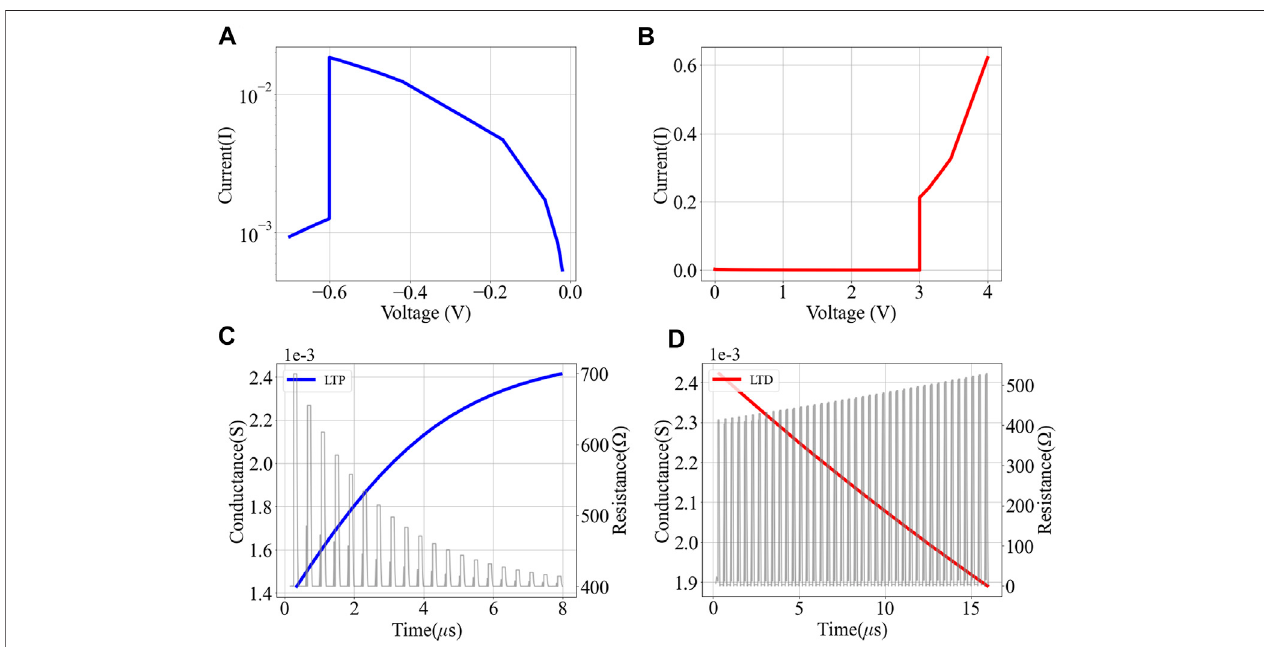
FIGURE 6 | Simulation results of ReSe 2 RRAM Verilog-A compact model using HSPICE. Simulated I-V curve of (A) RESET and (B) SET under DC sweep. No current compliance was applied to the simulation, causing an increasing current response after passing the threshold voltage of SET. Simulated (C) long-term potentiation, and (D) long term depression.